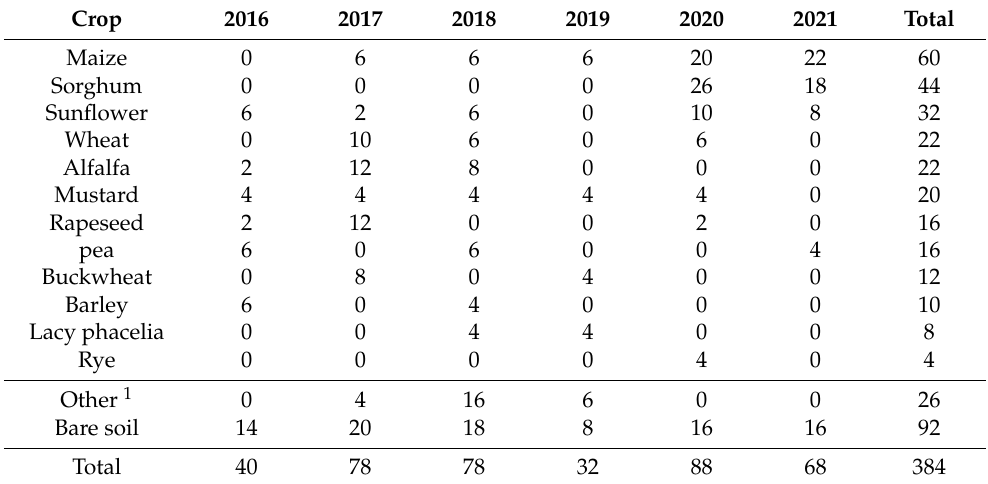
Table 1. Overview of experiments throughout